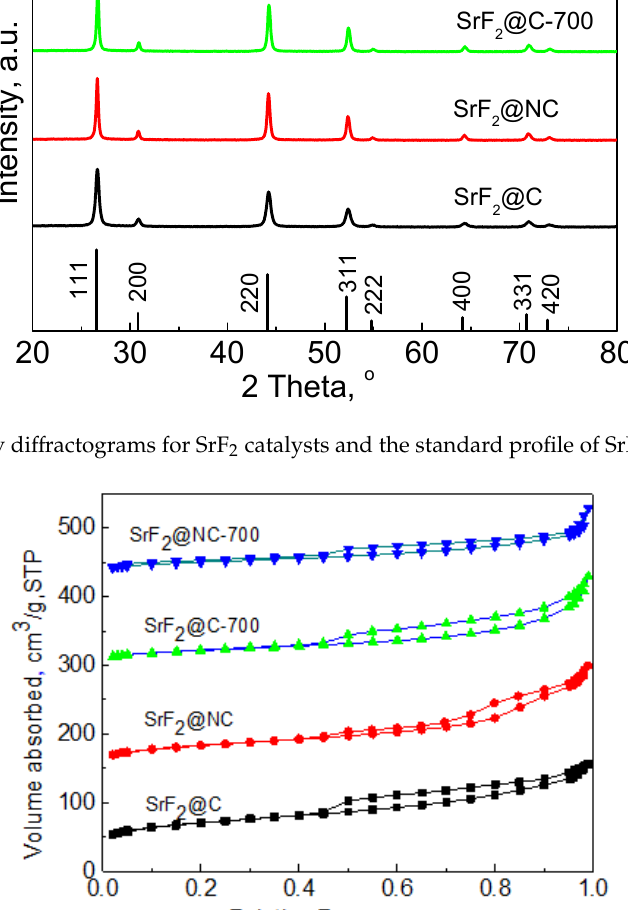
Figure 9. N 2 adsorption-desorption isotherms of SrF 2 @C, SrF 2 @C-700, SrF 2 @NC, and SrF 2 @NC-700.